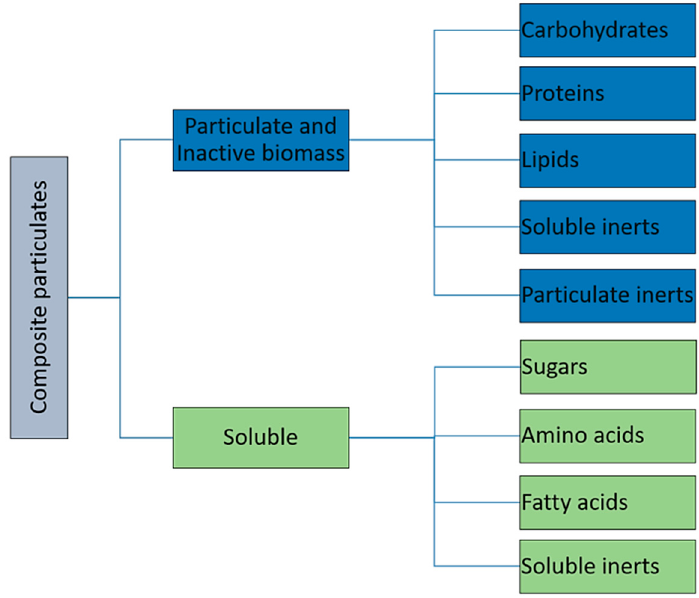
Figure 3. Composite particulate fractions according to the Anaerobic Digestion Model No. 1 (ADM1) model. Particulate contents and dead biomass undergo disintegration and hydrolysis to become soluble.